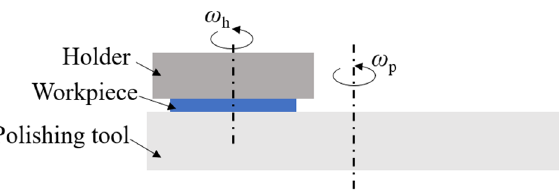
Figure 1. Diagram of polishing principle.